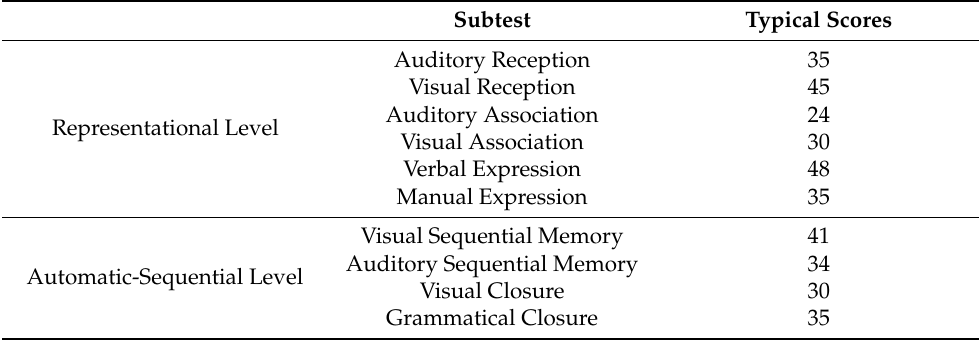
Table 3. Typical Scores obtained by the participant in the Illinois Test of Psycholinguistic Apti- tudes